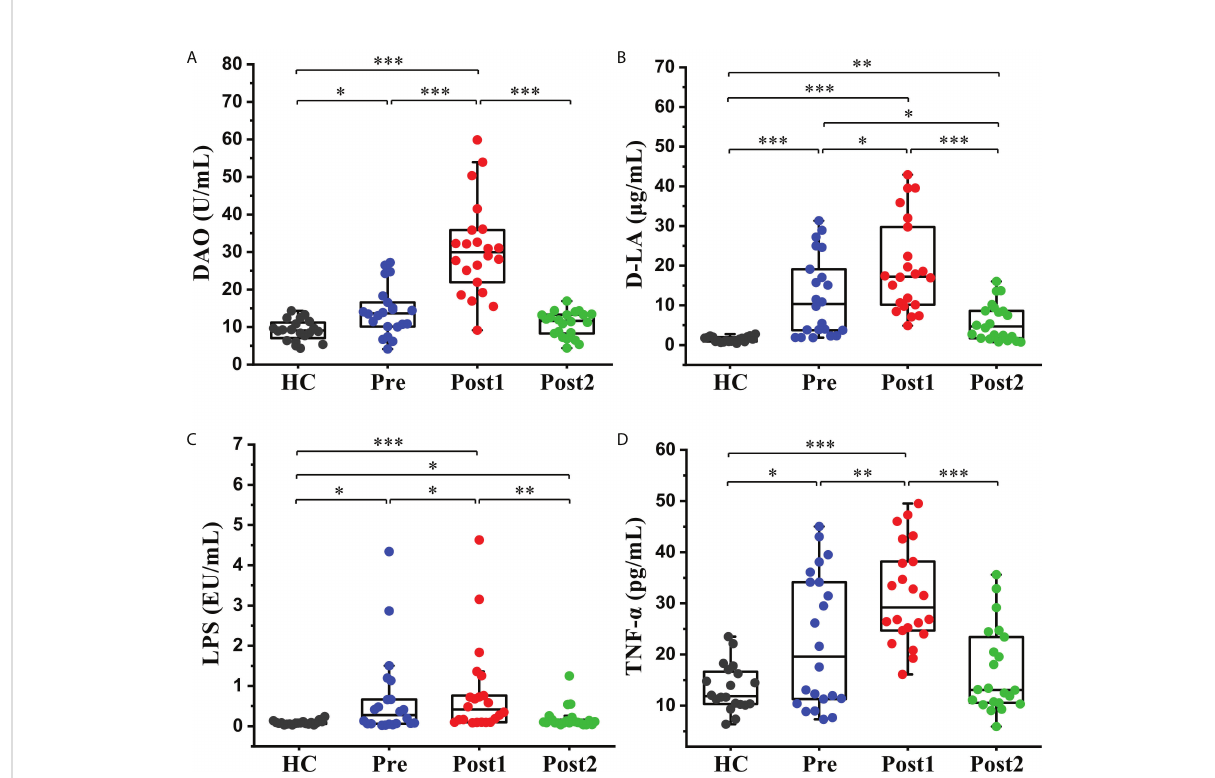
FIGURE 6 Alterations in the intestinal permeability and systemic in fl ammatory indices in peripheral blood. (A) Serum DAO, (B) D-LA, (C) LPS, and (D) TNF- a levels in the healthy control group ( n = 20) and cirrhotic patients ( n =22) before and after the SPD. Box plot illustration is provided in Figure 2 , * P < 0.05, ** P < 0.01, *** P <